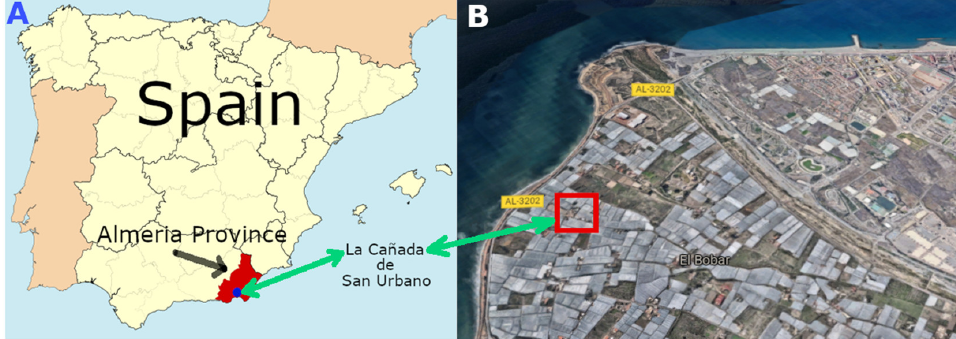
Figure 6. Location of the greenhouse in the Cañada de San Urbano in the province of Almeria. ( A ) On the map of Spain. ( B ) Satellite Image.